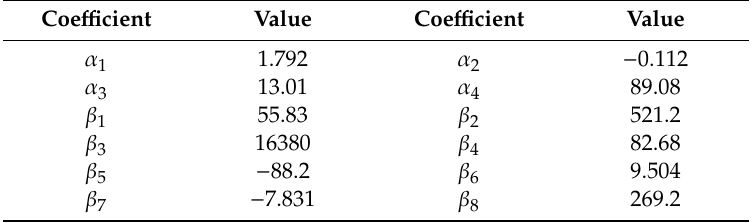
Figure 4. Establishment of DPF and its application process for amorphous damage profile prediction. Table 1. Coe ffi cients of DPF function for the single-crystalline